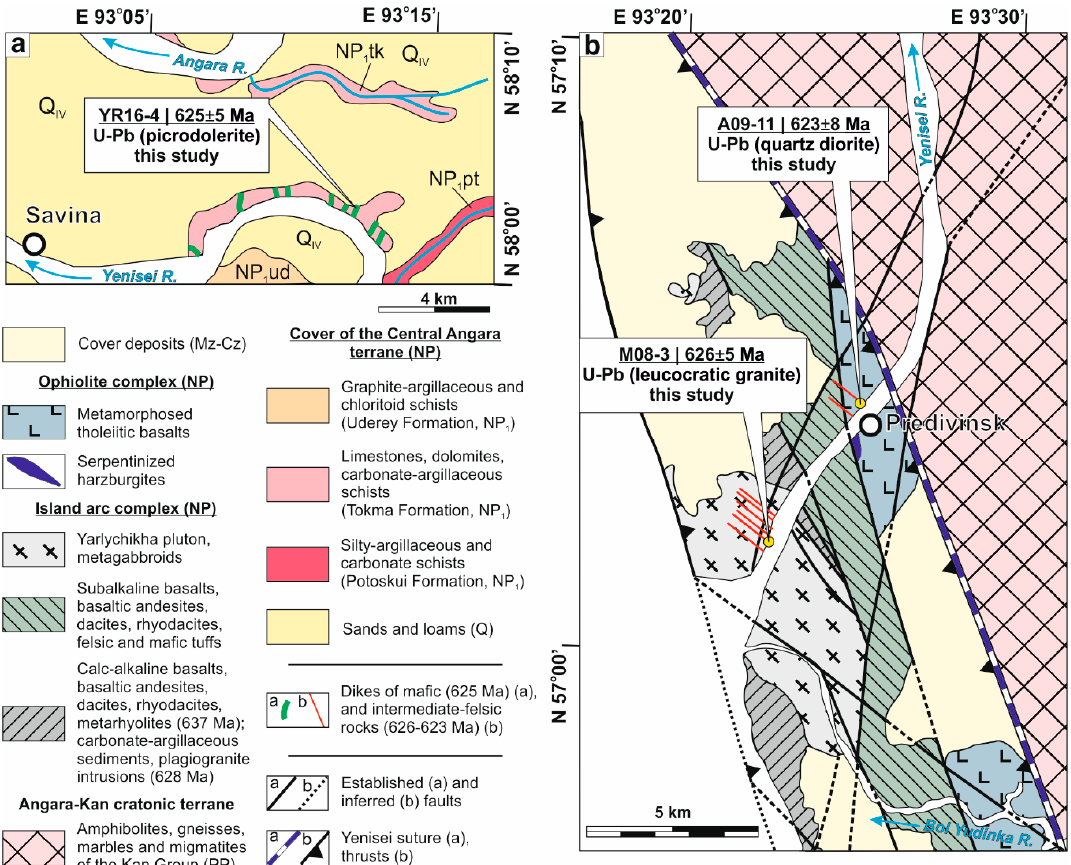
Figure 2. Position of the Ediacaran mafic rocks from dikes in the southwestern margin of the Central Angara terrane of the Yenisei Ridge, Savinsky Rock location, modified from state geological maps ( a ) and of the intermediate-felsic rocks from dikes in the imbricated structure of the Predivinsk island arc and ophiolite terrane, modified after [24] ( b ).